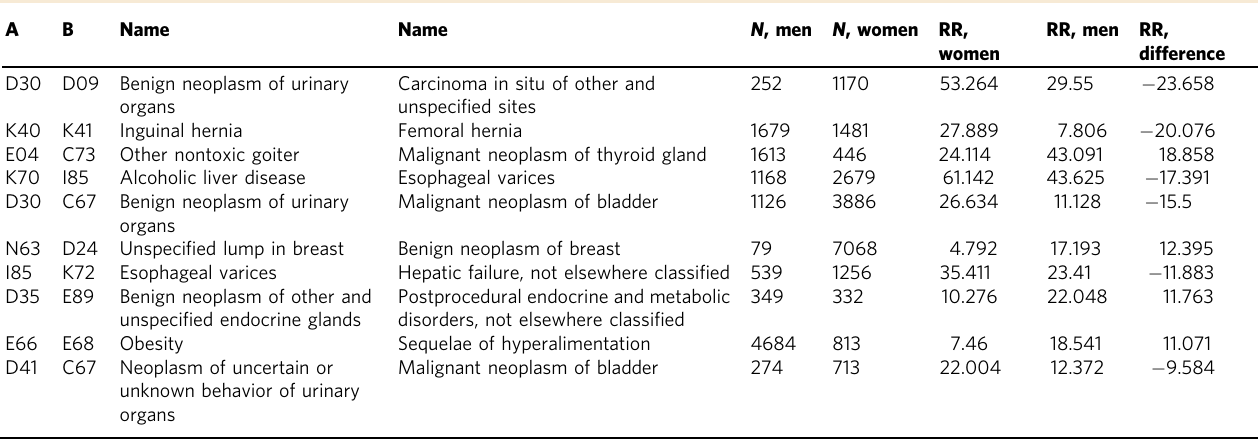
Table 2 Directional pairs used to construct linear